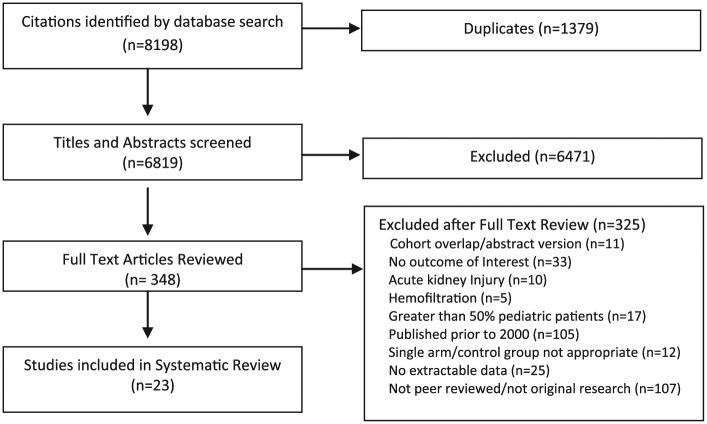
Study flow diagram.